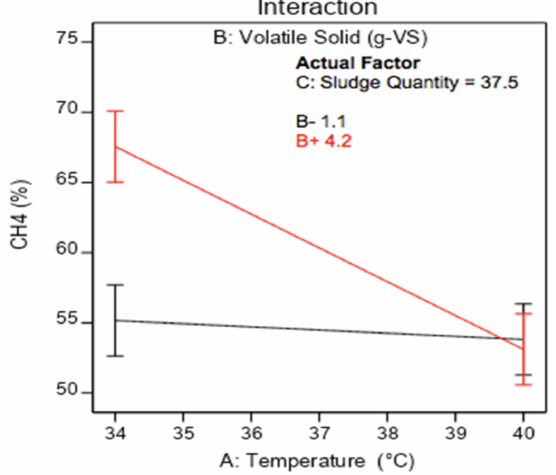
Figure 12. Interaction plot illustrates the effect of interaction between temperature and volatile solid on CH 4 %.